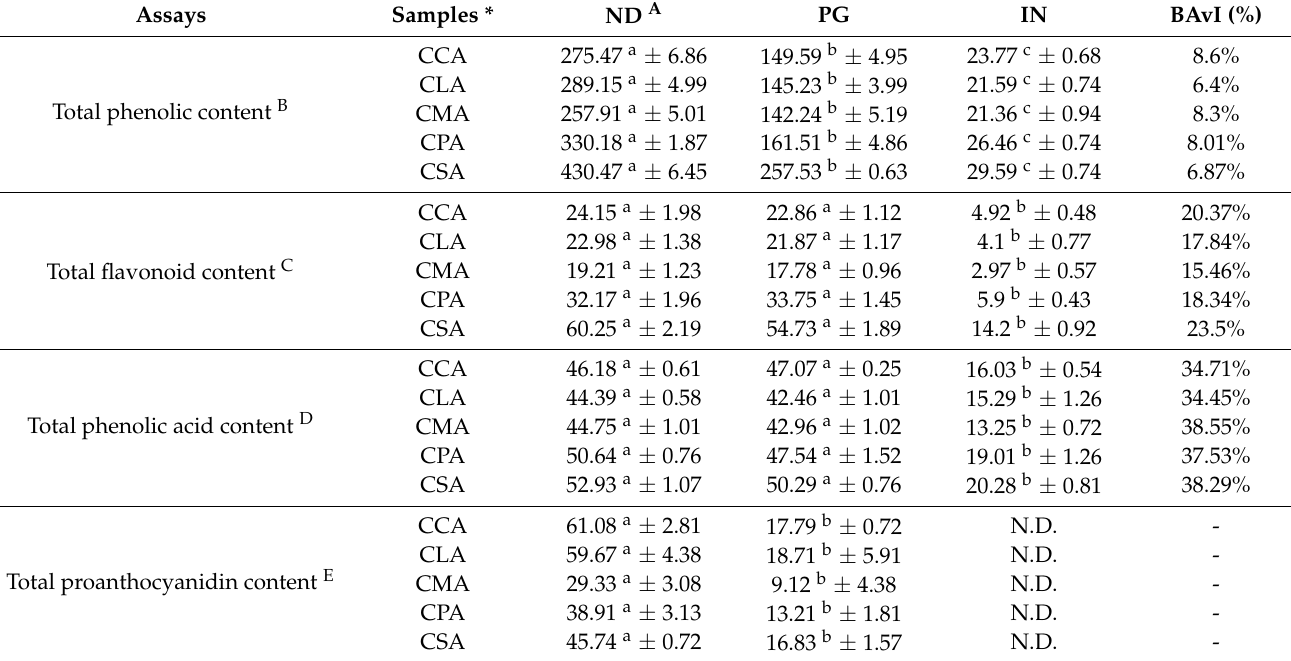
Table 1. Spectrophotometric determination of phenolic profile of Cistus extracts and their bioavailability indexes.